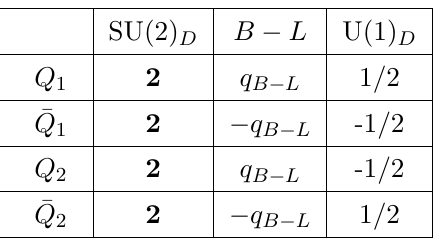
Table 1 . The charge assignment of the minimal model with N c = 2 and N f = 2. The QED 0 charges of dark quarks are normalized to be (cid:6) 1 = 2 without loss of